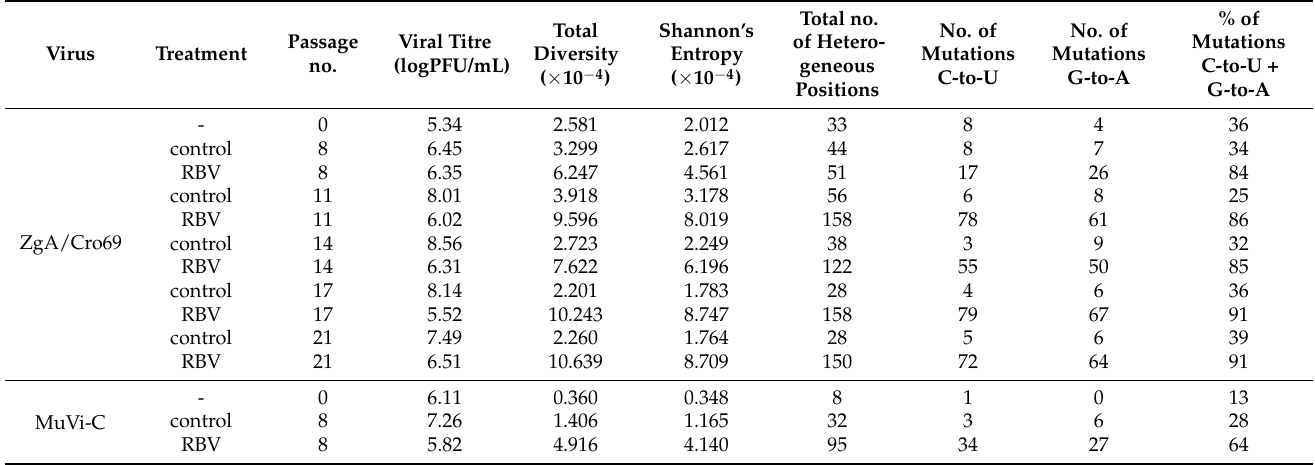
Table 2. Genetic characterization of RBV-treated (62.5 µ M) and control ZgA/Cro69 and MuVi-C viruses from serial passages in Vero and A549 cells, respectively, based on full-length genome sequences.